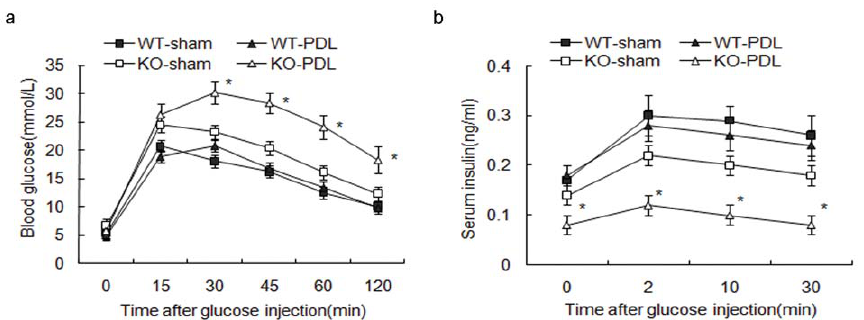
Figure 4. Absence of survivin in beta cells leads to glucose intolerance after PDL. (a) At PDL day 7, female RIPCre + Survivin fl/fl mice exhibit markedly higher glucose excursions during an IPGTT compared with other groups (n=10 per genotype). (b) In vivo GSIS after i.p. glucose injection is markedly compromised in the mutant mice compared with that in other groups (n=10 per genotype). & , RIPCre + Survivin + / + sham day 7; % , RIPCre + Survivin fl/fl sham day 7; m , RIPCre + Survivin + / + PDL day 7; g , RIPCre + Survivin fl/fl PDL day 7. The data represent as means 6 SE. *, p , 0.05 vs sham operation.